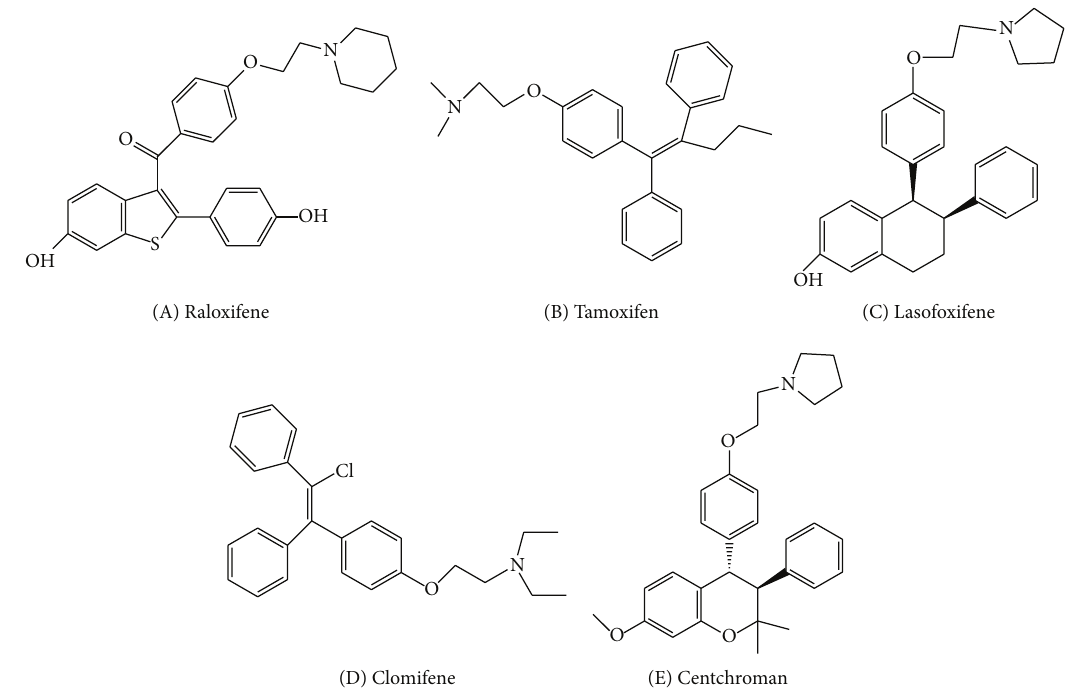
Figure 1: Examples of biologically active heterocyclic